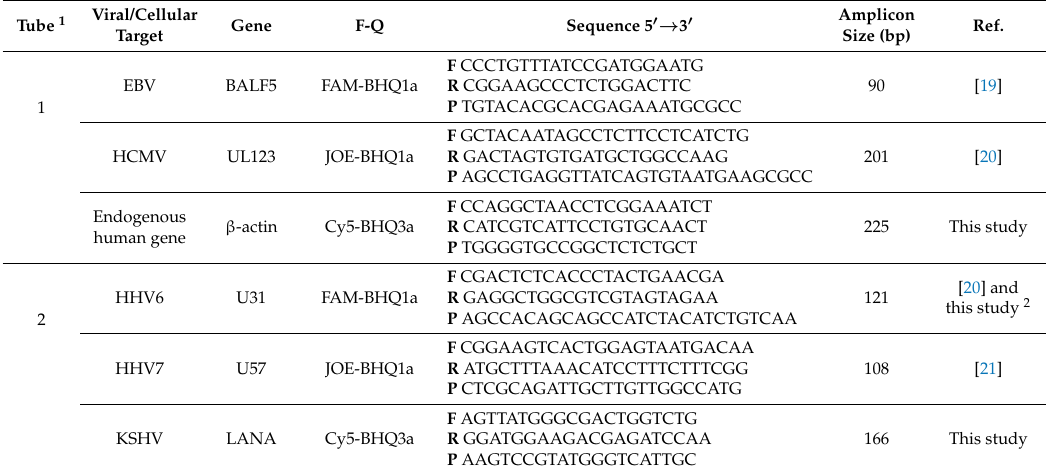
Table 1. Characteristics of primers and probes used in two-tube multiplex qPCR for detection of beta and gamma